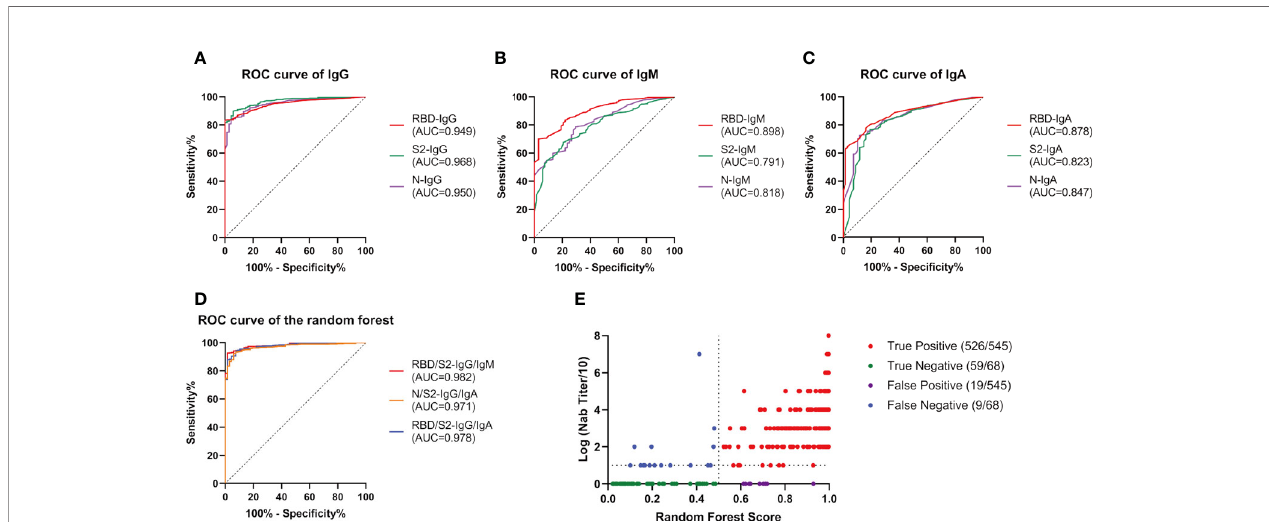
FIGURE 4 | Random Forest ef fi cacy with various indicators. We constructed a random forest model to predict the Nab titers (divided by 1:20) from the tested immunoglobulins. ROC curve of IgG (A) , IgM (B) , and IgA (C) as a single indicator. (D) ROC curve of the indicator combinations. (E) Performance of RBD/S2-IgG/ IgM in the random forest plot, every dot represents a sample, red, green, purple, and blue represent true positive, true negative, false positive, false negative respectively. AUC, area under curve; Ig, immunoglobulin; N, nucleocapsid protein; Nab, neutralizing antibodies; RBD, receptor-binding domain; ROC, receiver operating characteristic; S,